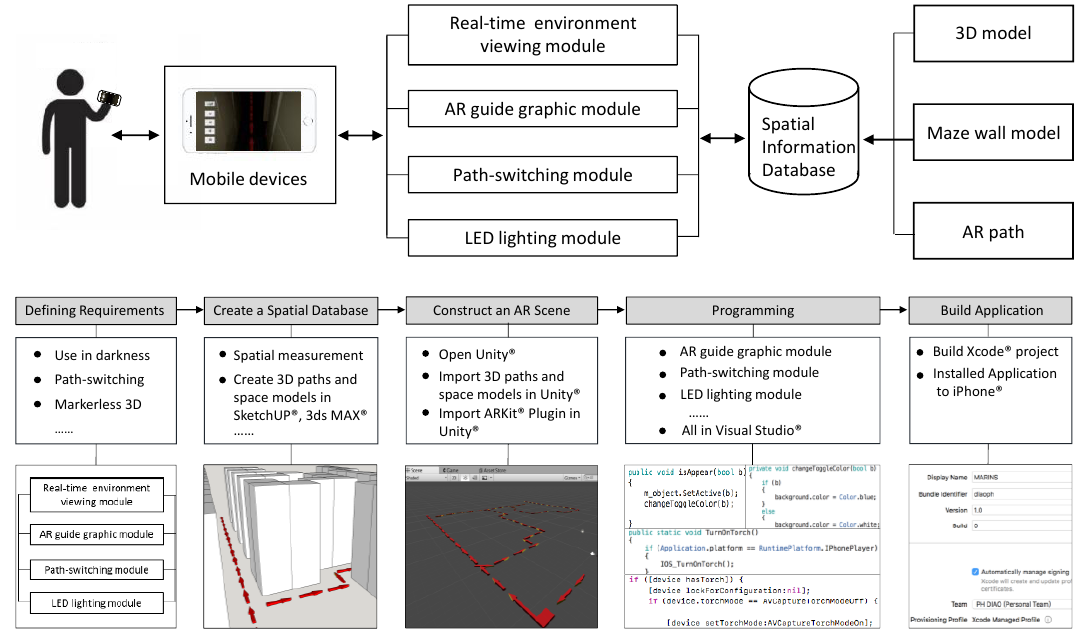
Figure 1. System structure ( top ) and development diagram ( bottom ) of MARINS.